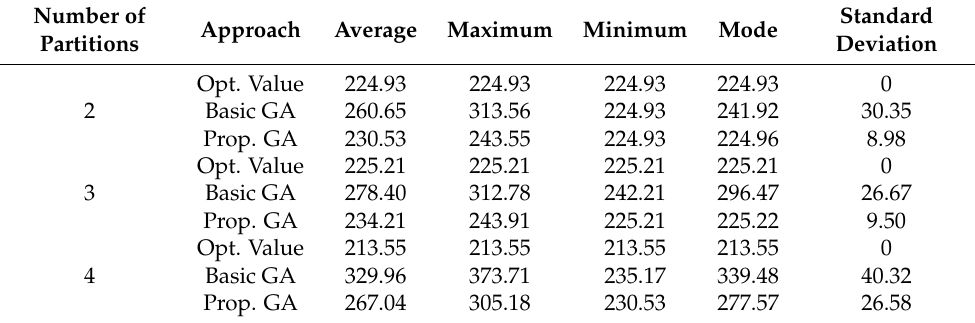
Figure 8. Performance comparison on partitioning B-ResNet by considering partitioning and de- ploying simultaneously. ( a ) Comparison on average total execution time. ( b ) Comparison on device- average energy cost. Table 9. Comparison of B-AlexNet total execution time in deploying to three to six